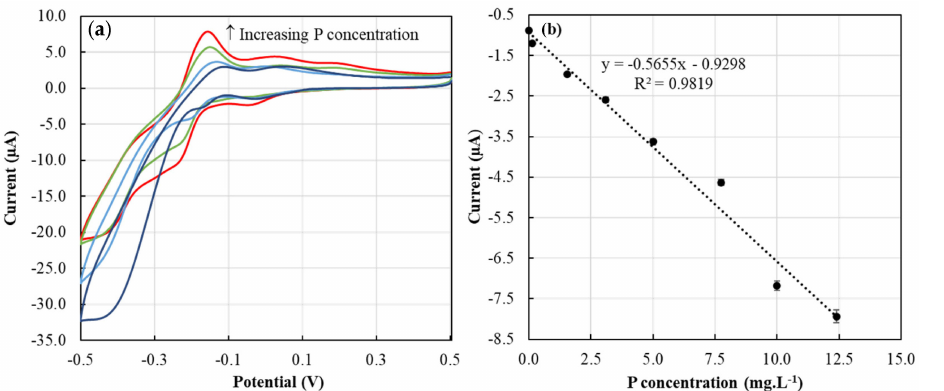
Figure 6. ( a ) Cyclic voltammograms of 1 ERR IFP suspended in 0.5 mL of ▬ 10 mg·L − 1 , ▬ 7.74 mg·L − 1 , ▬ 3.10 mg·L − 1 , and ▬ 0.15 mg·L − 1 of P standards for two minutes; ( b ) calibration curve corresponding to P standard solutions.